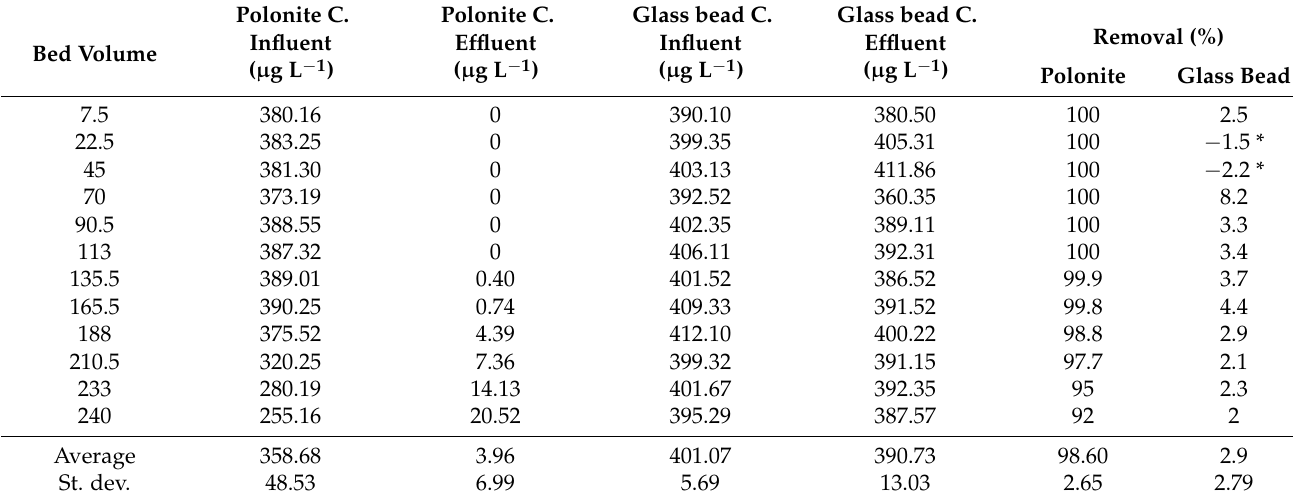
Table 2. Phosphate concentration and removal in hypolimnetic water before (influent) and after (effluent) treatment in Polonite and glass bead columns. Average and standard deviation values are given for the consecutive bed volumes treated. * Calculated as zero